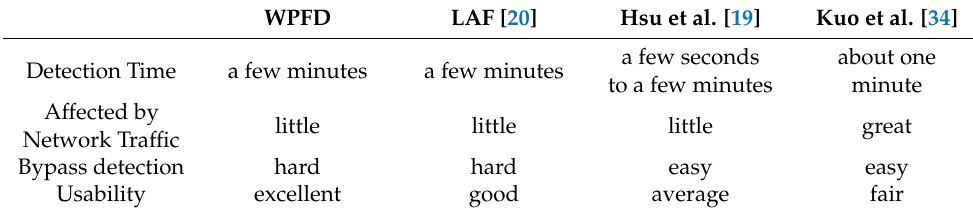
Table 4. Comparisons between WPFD and previous